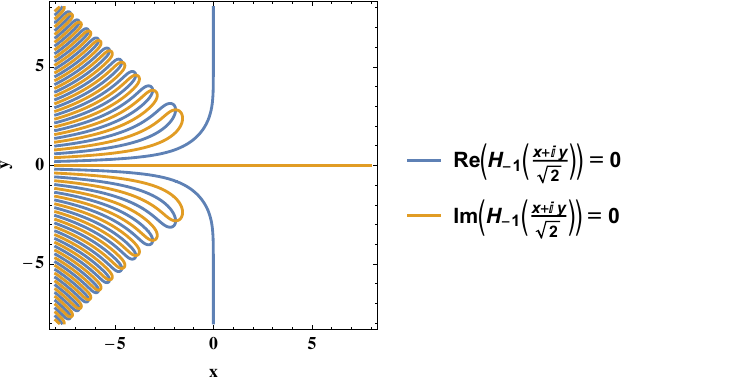
Figure 5 . Lines on the complex plane z = x + iy where the real and imaginary parts of H (cid:0) 1 are